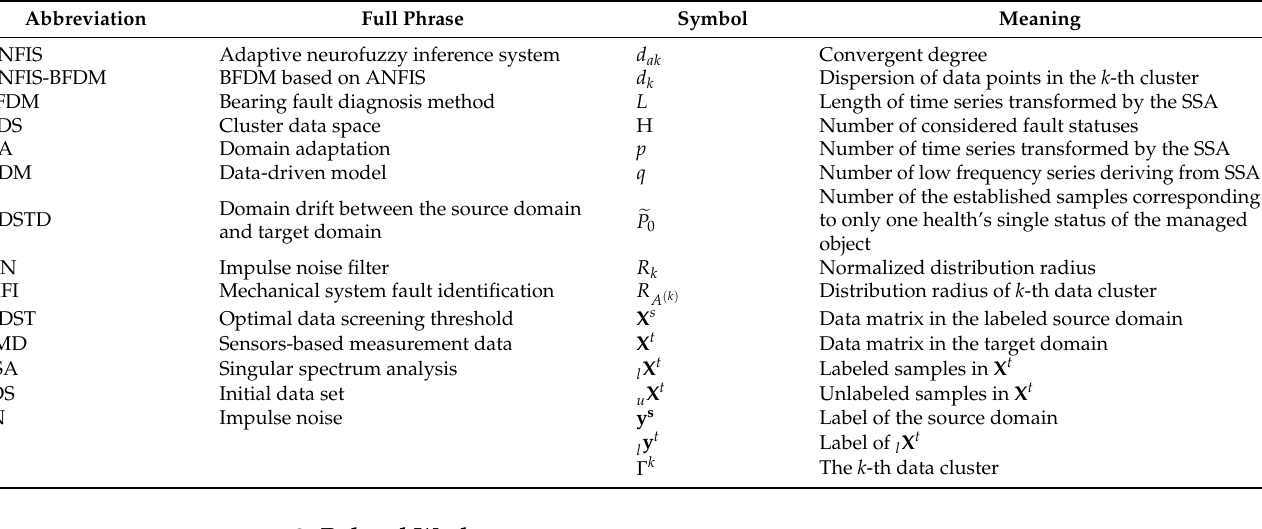
Table 1. Abbreviations and